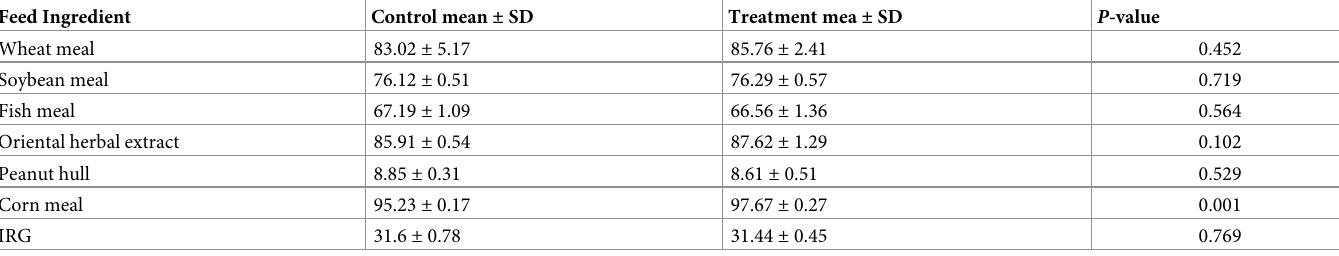
Table 2. IVID of feed ingredients (values are mean ± standard deviation, n =